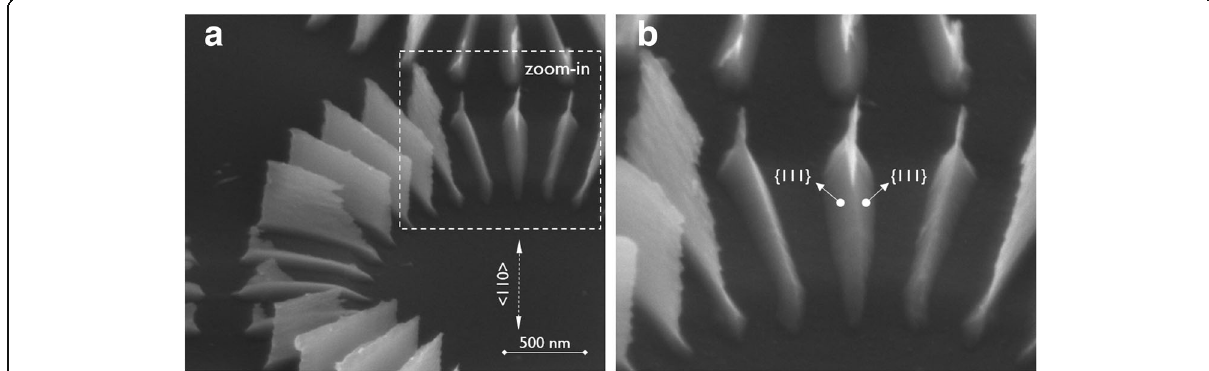
Fig. 3 a Tilted SEM image of a Si(100) wagon-wheel etched in low-concentration TMAH (5 wt.%) at RT and zoom-in ( b ) showing the slanted {111}